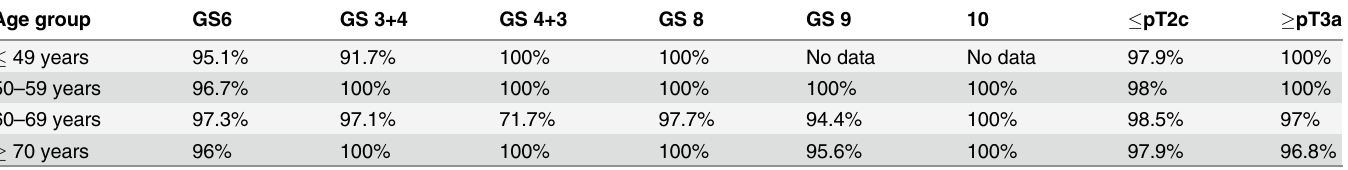
Table 5. Recognized tumors (%) biopsied according to “ old ” PSA cut offs stratified by age.